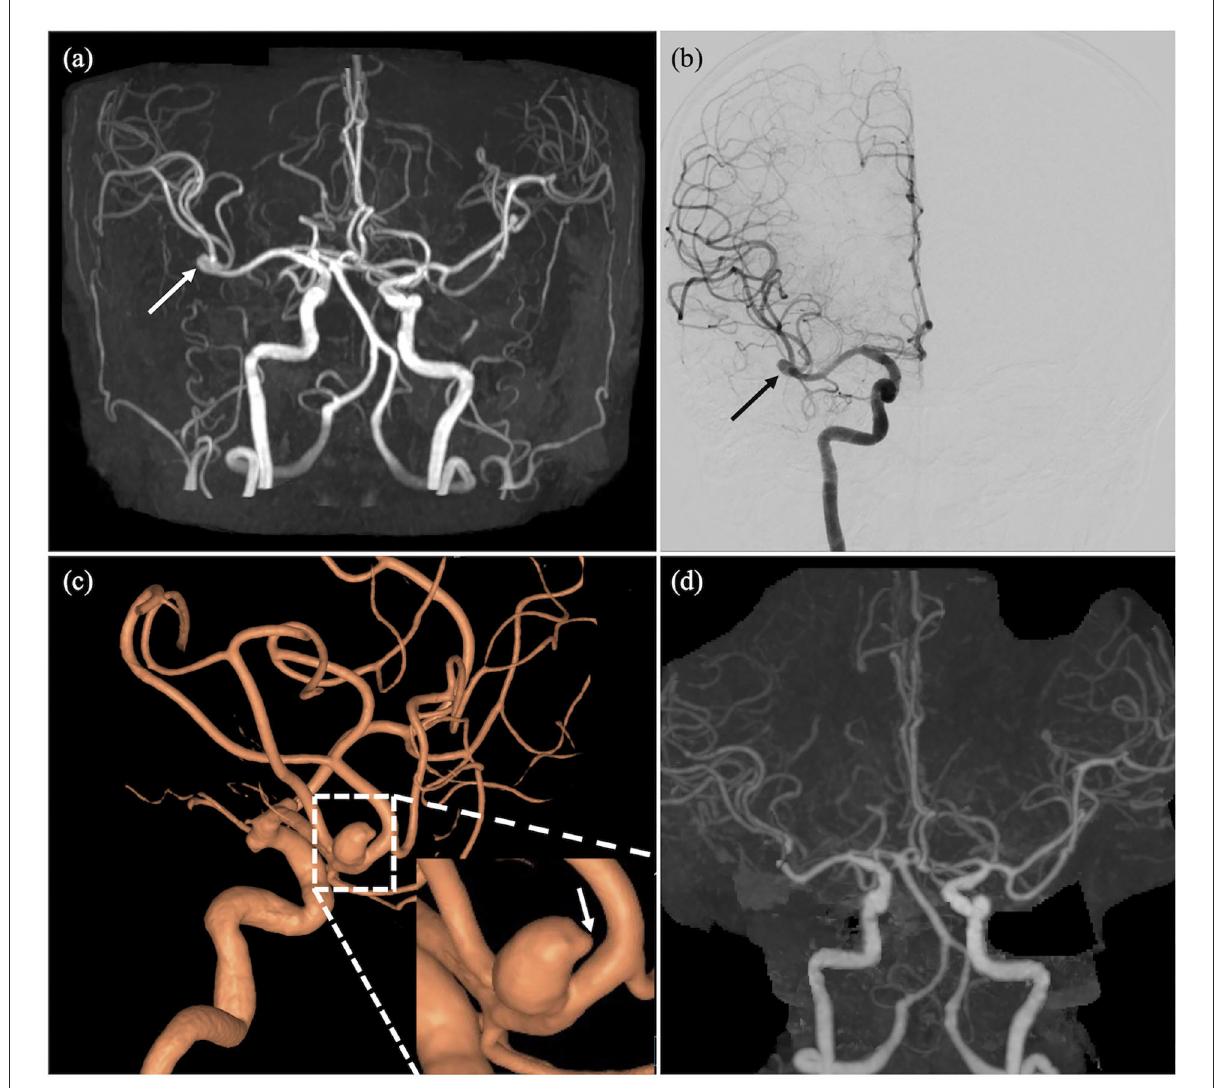
FIGURE2 An incidentally detected intracranial aneurysm in a 75 year-old-female with cognitive impairment. A 6.5-mm aneurysm (arrows) at right MCA bifurcation on TOF-MRA (a) and digital subtraction angiography (b) . A 3D reconstruction of a digital subtraction angiography of right ICA demonstrating the aneurysm at right MCA bifurcation with a bleb formation (arrow) at the aneurysmal dome (c) . TOF-MRA after surgical clipping shows no filling within the aneurysm and patent distal flow (d) .